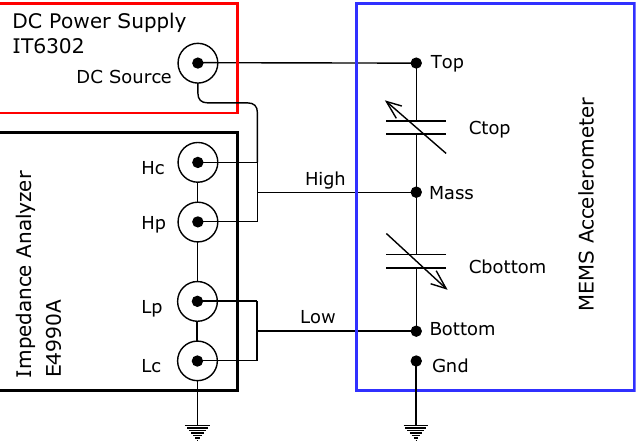
Figure 11. Measurement setup for the electrostatic actuation of the MEMS accelerometer.